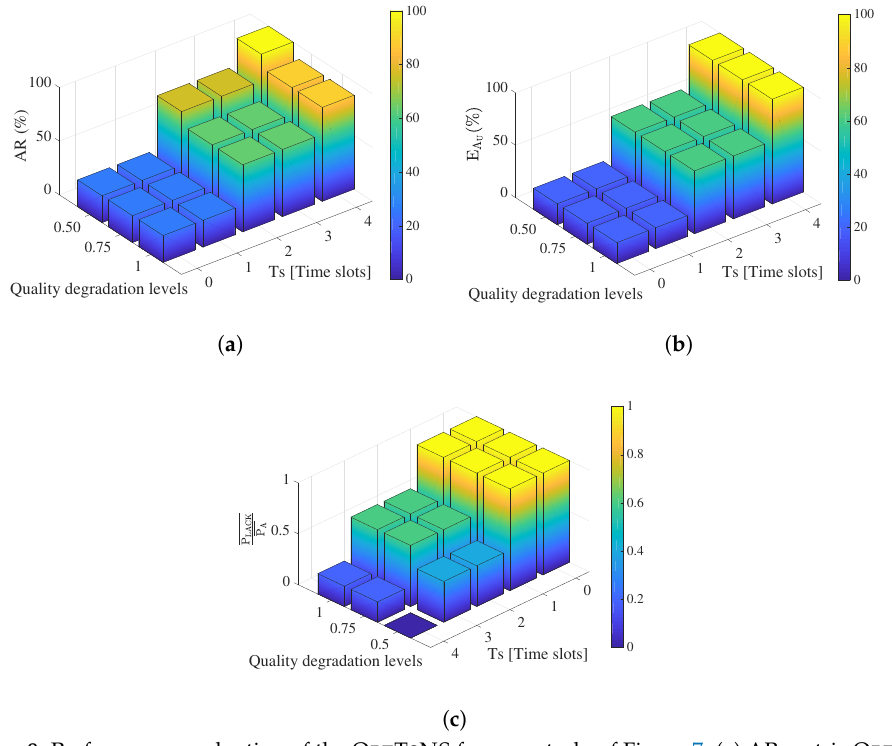
Figure 8. Performance evaluation of the O PT T S NS for case study of Figure 7: ( a ) AR metric O PT T S NS; metric O PT T S NS; and ( c ) P LACK metric O PT T S NS. Parameters: According Table ( b ) E A U